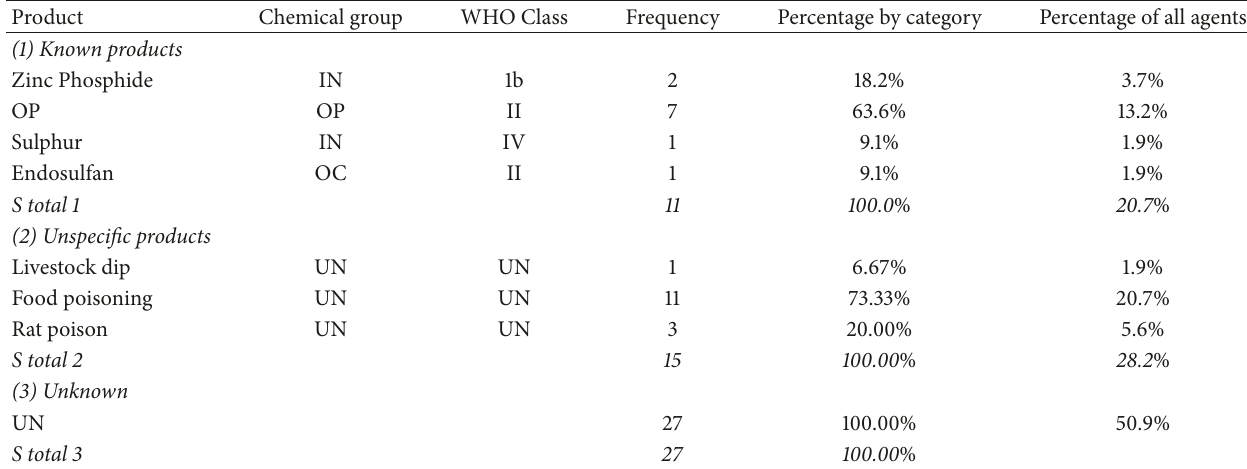
Table 2: Classification of agents responsible for APP in children in